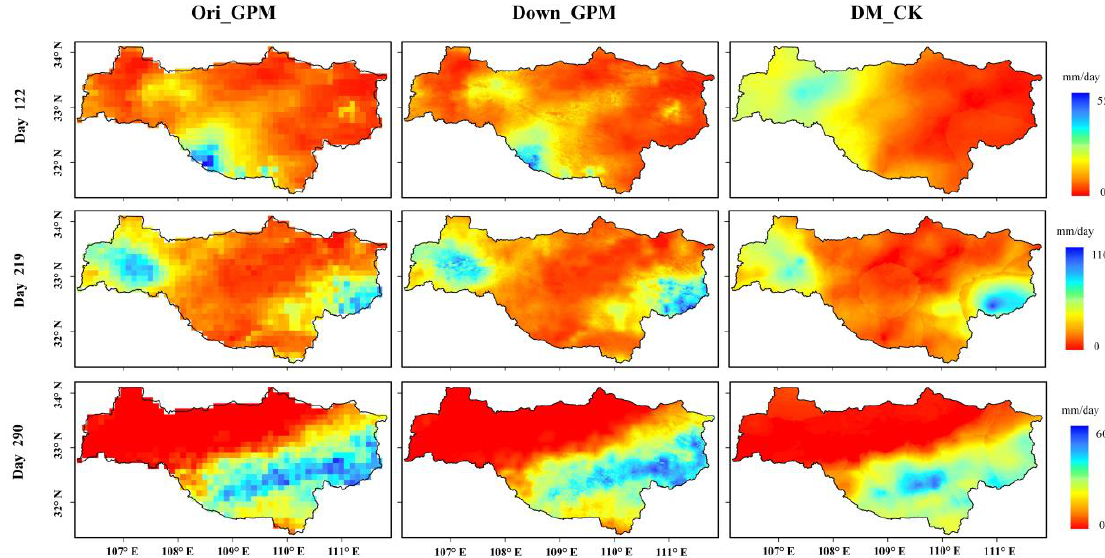
Figure 5. Precipitation maps of Ori_GPM: the original GPM precipitation, Down_GPM: the downscaled GPM precipitation